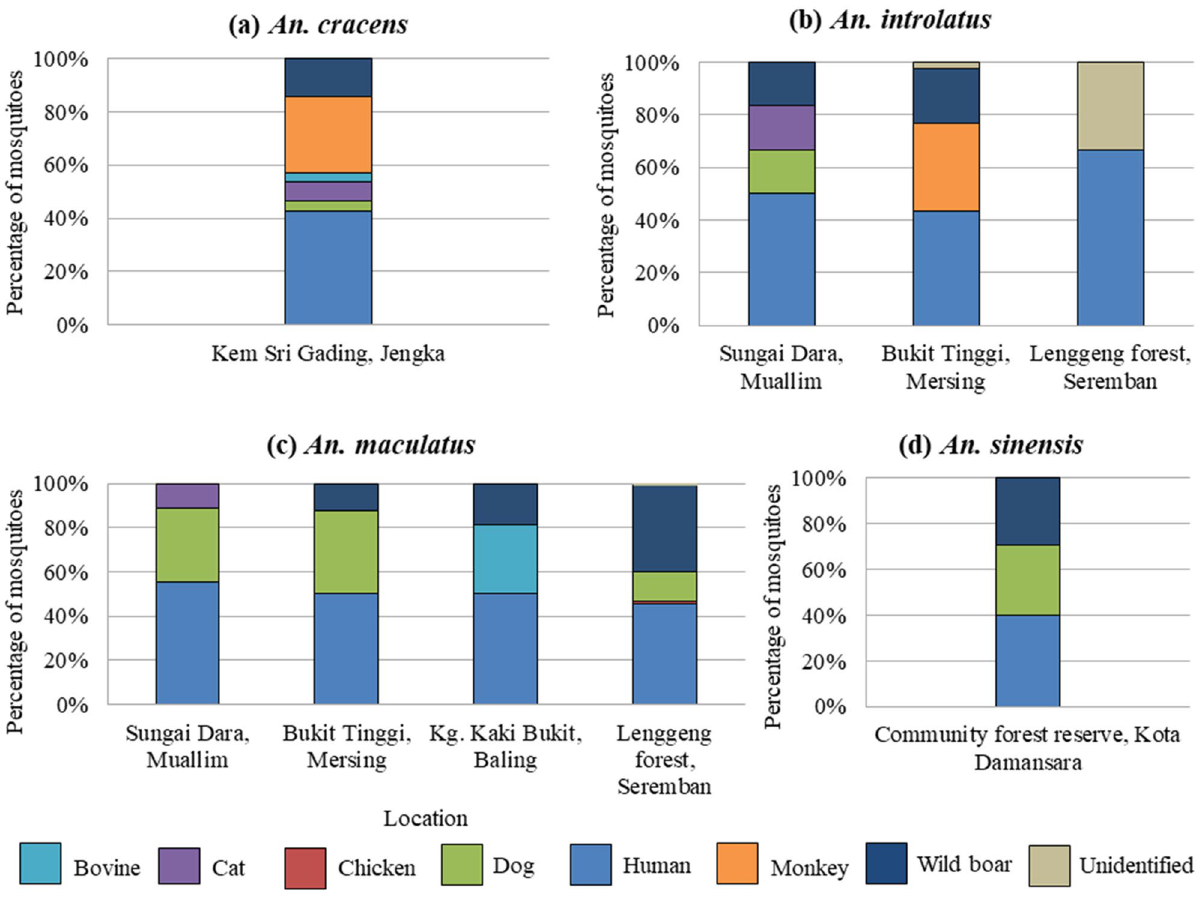
Figure 4. Source of blood meal of four predominant Anopheles species ( a ) An. cracens , ( b ) An. introlatus , ( c ) An. maculatus and ( d ) An. sinensis according to sampling